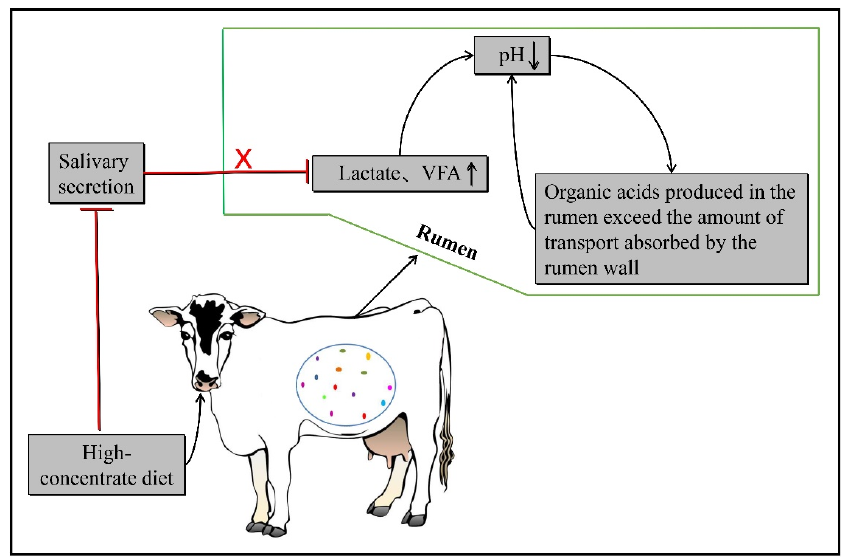
Figure 2. Pathogenesis of SARA in dairy cows.